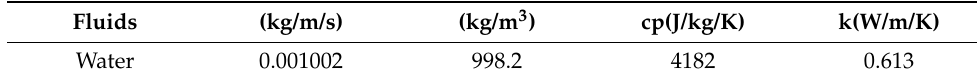
Table 1. Water physical properties.